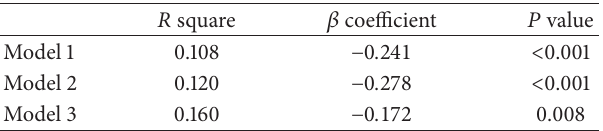
Table 4: Multiple linear correlation analysis between BMD and NALFD. 𝑅 square 𝛽